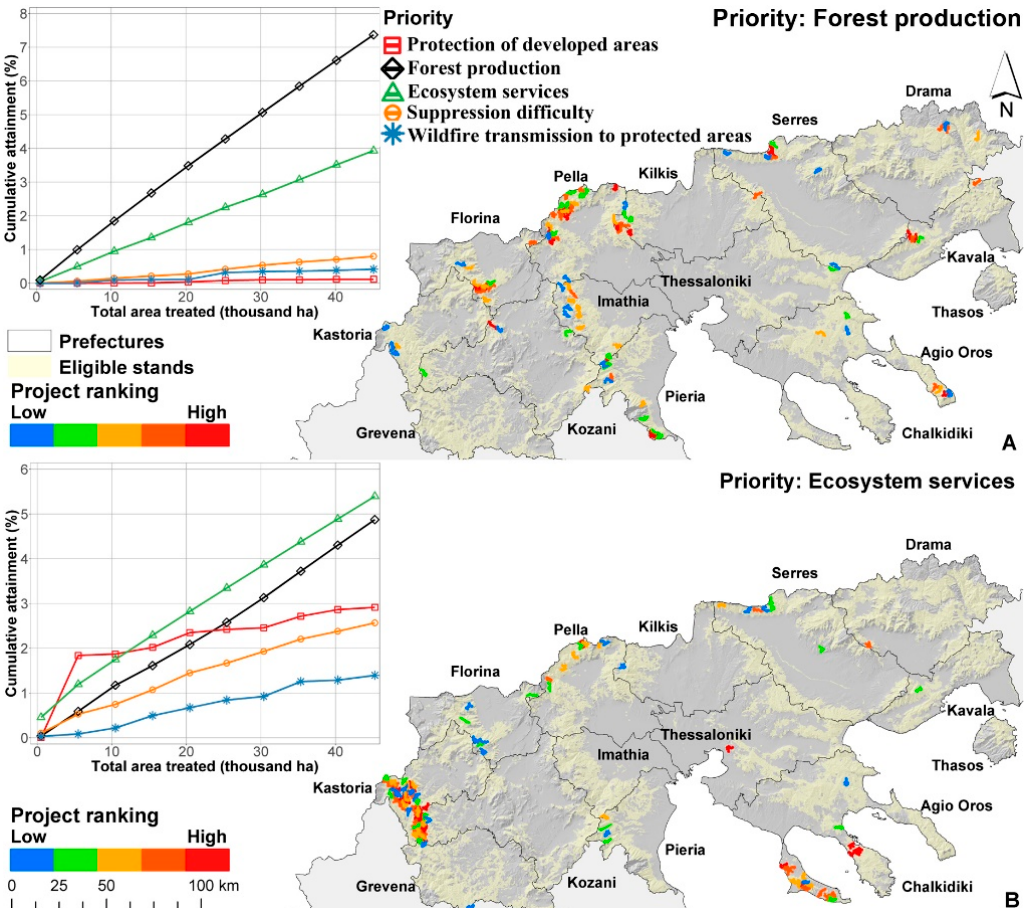
Figure 4. ( A ) Prioritization of forest production. ( B ) Prioritization of ecosystem services. All projects were ranked from lowest to highest attainment. Graphs on the left show the cumulative percent attainment of each of the five priorities if the 100 projects on each map receive fuel treatments.